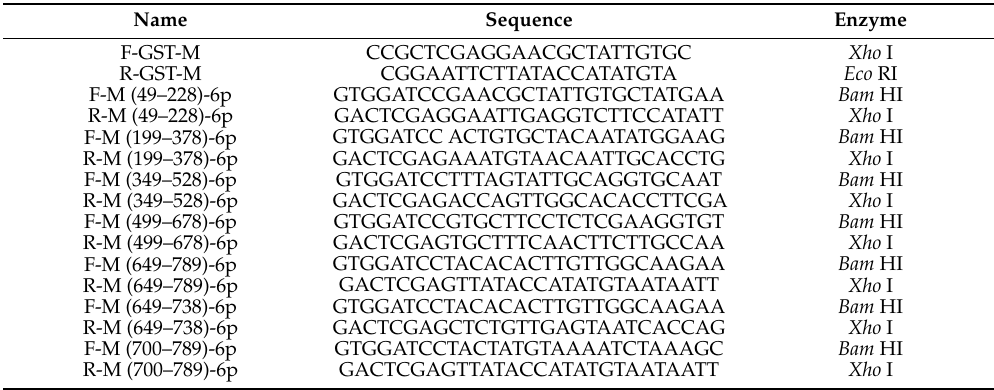
Table 1. Primers used in this